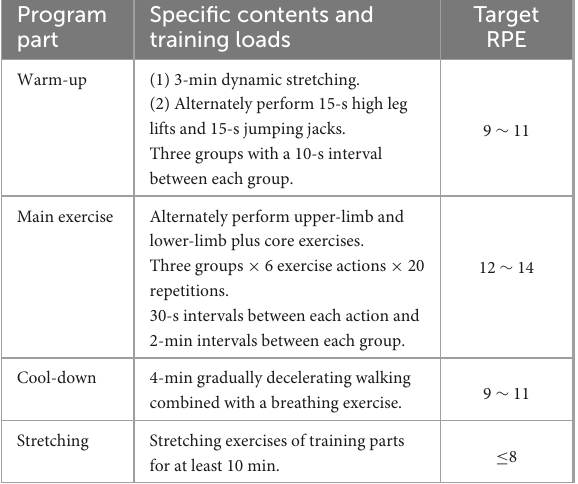
TABLE 2 Stage I resistance training